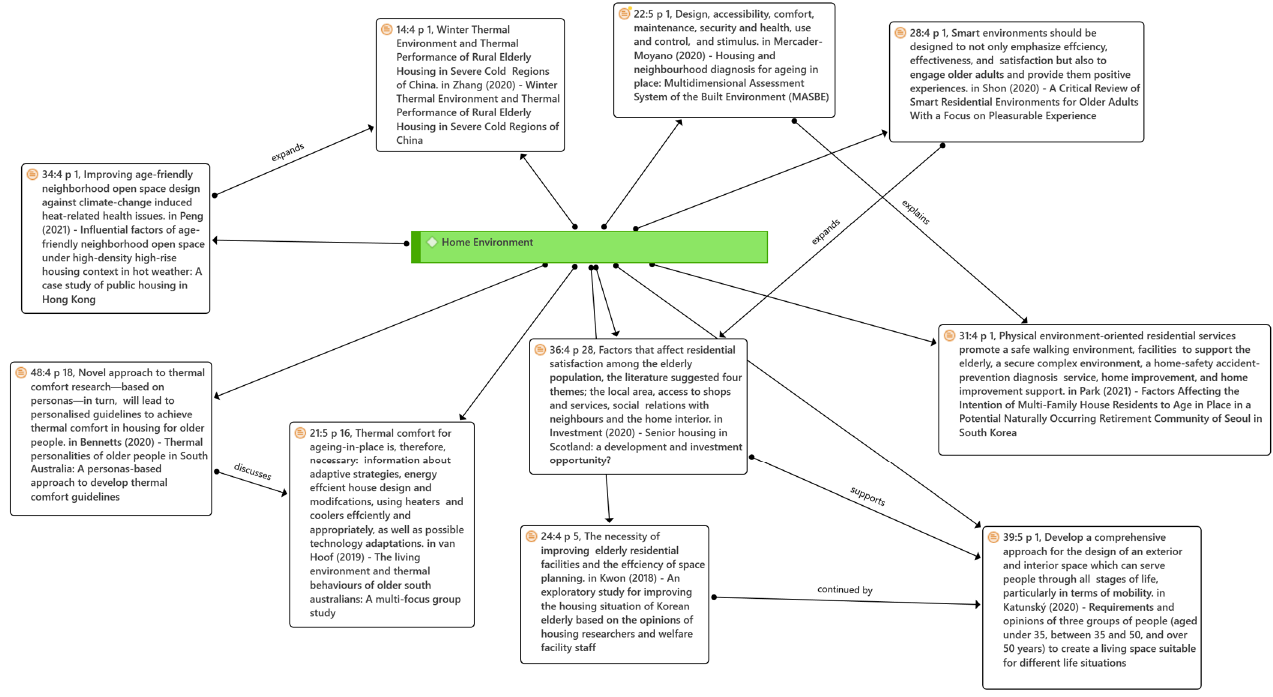
Figure 7. Home environment theme.